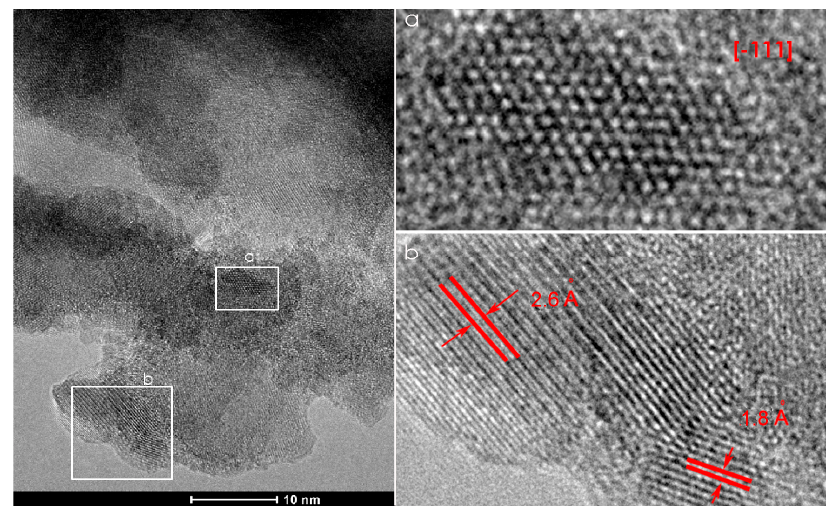
Figure 4. TEM (left) and HRTEM ( a , b —right) of CCT3RO sample. High-angle annular dark-field STEM and corresponding EDXS elemental mapping presented in Figure 5 implies the homogeneous distribution of Ca, Cu, Ti, Ru and O in CCT3RO particles, independently of their size.